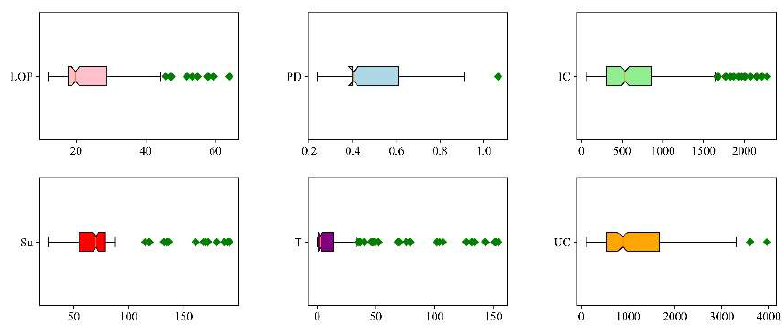
Figure 4. Six input parameters and their box plots.